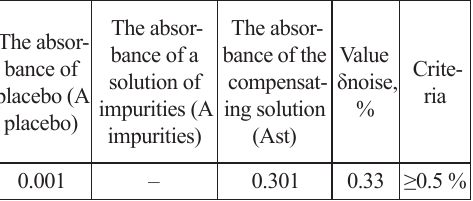
Fig. 3. Graph of the dependence of the amount of absorbance on the composition of the isomolar solution: C – 1.6×10 –4 M metoprolol 1 tartrate solution; C – 1.6×10 –4 M solution BCG) at 624 nm 2